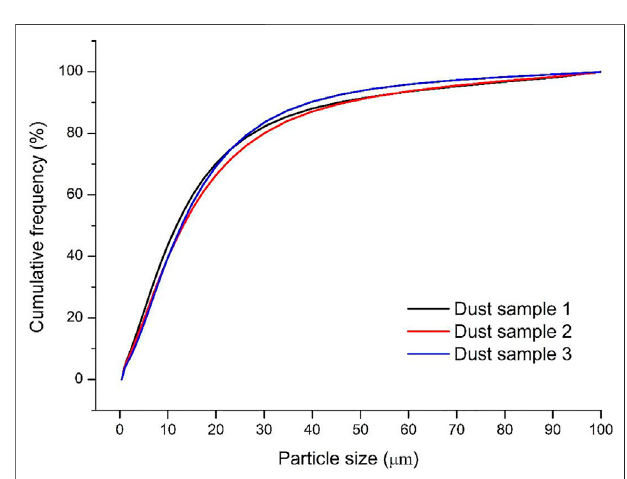
the Mogao Grottoes.